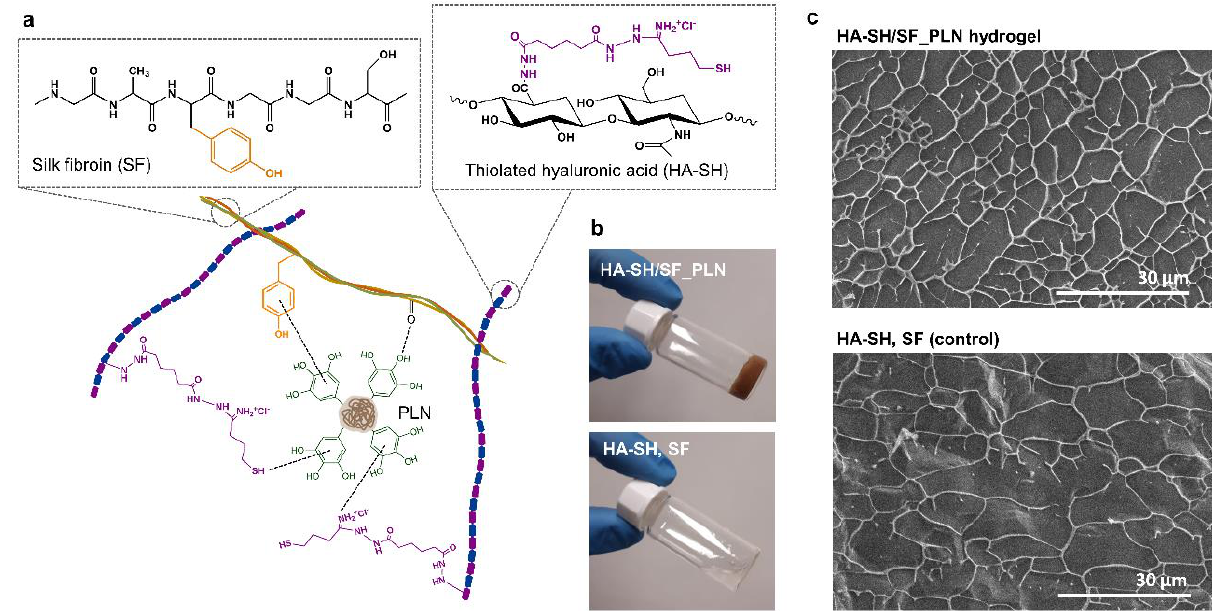
Figure 1. ( a ) Schematic representation of the non-covalent interactions forming the self-assembling HA-SH/SF_PLN hydrogel; ( b ) pictures of the gel obtained by mixing thiolated hyaluronic acid (HA-SH), silk fibroin (SF), and phenolated lignin nanoparticles (PLN), and the non-gelating HA-SH and SF mixture; and ( c ) cryo-SEM images of the hydrogel (HA-SH/SF_PLN) and the control without PLN (mixture of HA-SH and SF).